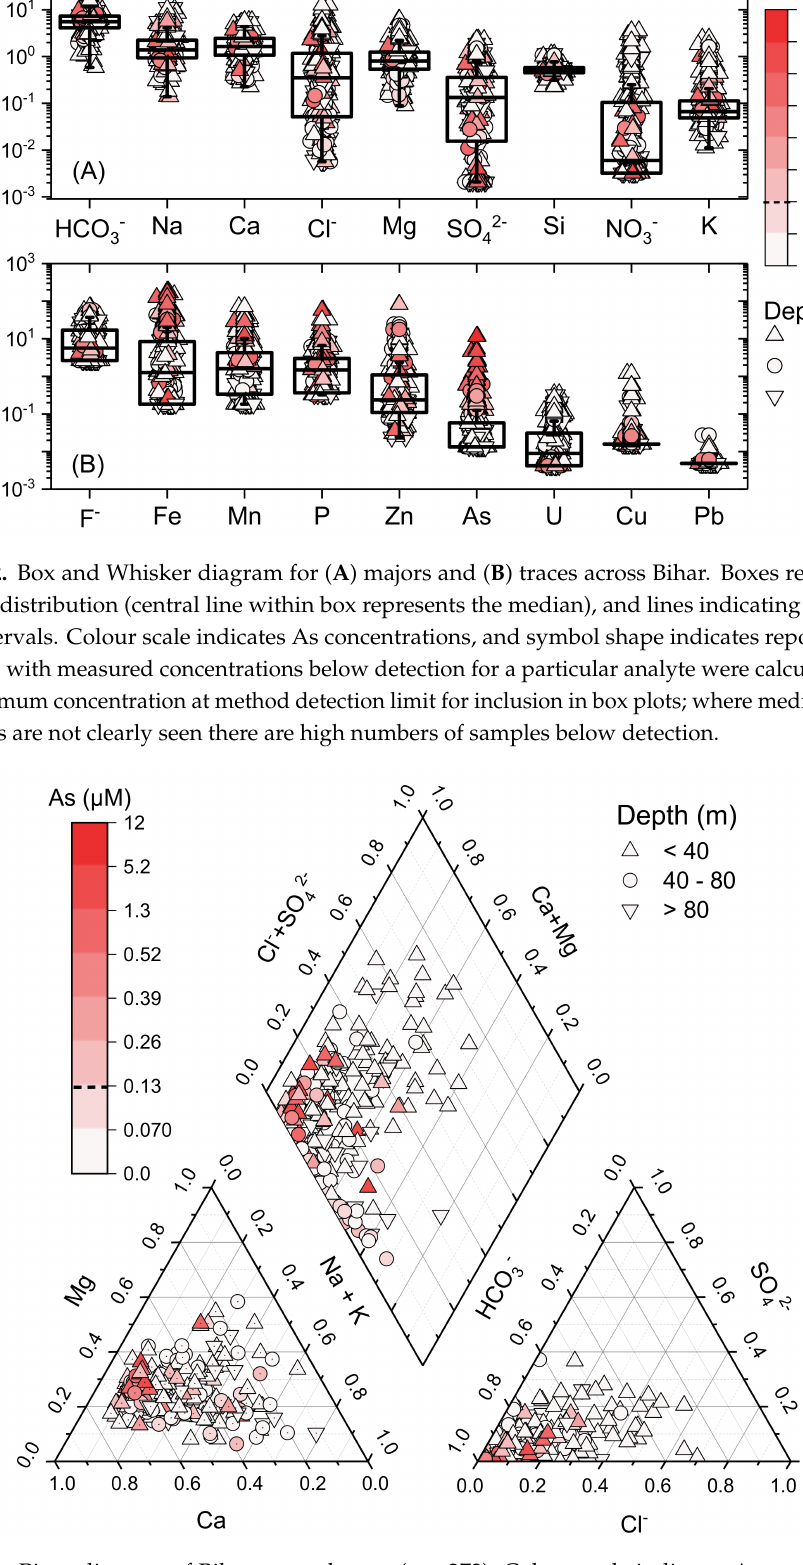
Figure 3. Piper diagram of Bihar groundwater ( n = 273); Colour scale indicates As concentrations, and symbol shape indicates reported